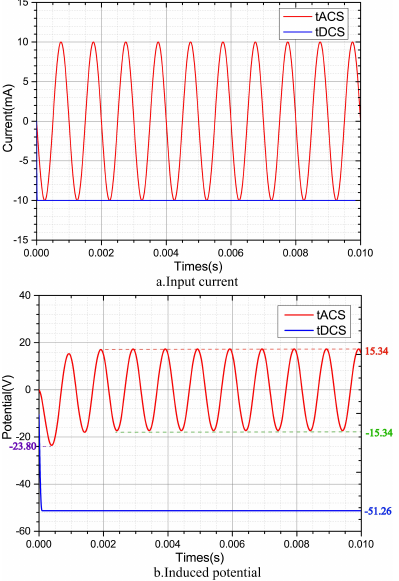
Figure 2. Input current signal and induced coupling potential. ( a ) The current signal waveform injected into the body through electrodes. ( b ) The strength of the coupling potential at the contact surface between the electrode and the body.